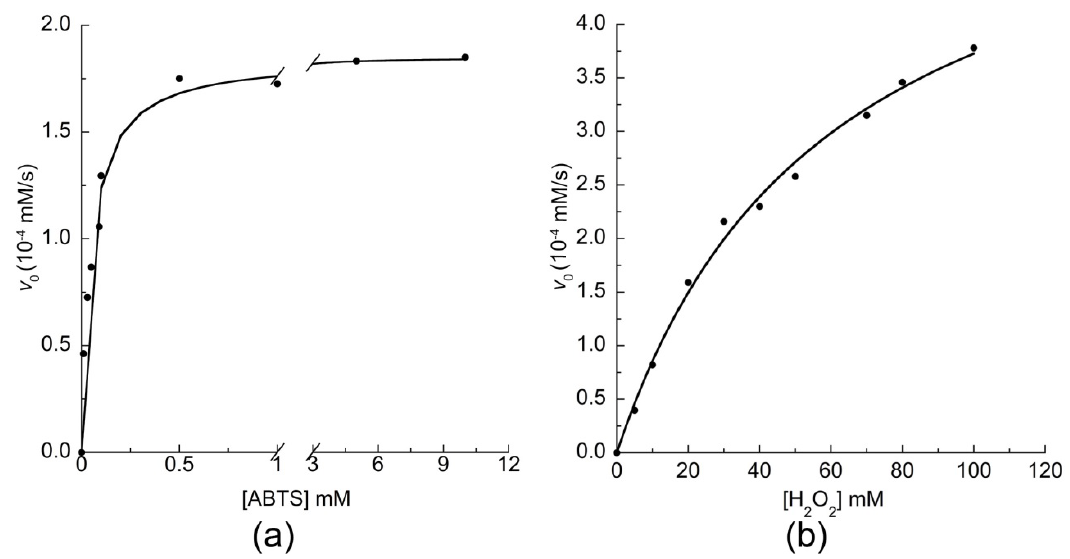
Figure 5. Peroxidase activity of MIMO@LA@AuNPs: ( a ) initial rate dependence towards ABTS concentration; and ( b ) initial rate dependence towards H 2 O 2 concentration. Reaction conditions were: 50.0 mM phosphate buffer pH 6.5 50% TFE ( v / v ); MIMO@LA@AuNPs enzyme concentration 3.5 ×